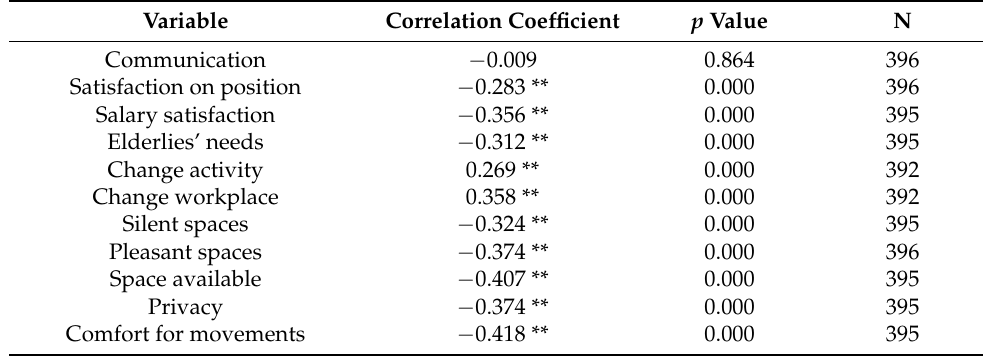
Table 7. Spearman correlations of workplace characteristics with moral distress